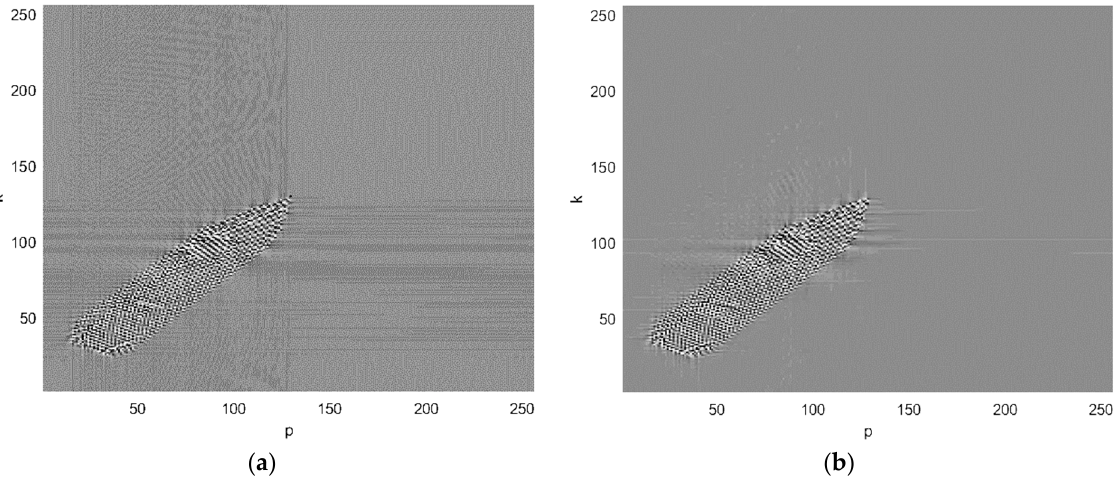
Figure 6. The quadrature components of the azimuth compressed SAR signal after its range compression, the real part ( a ) and the imaginary part ( b ).